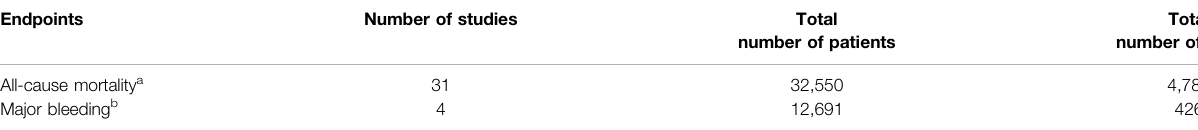
TABLE 2 | Number of events according to each endpoint in patients treated or not with heparin.